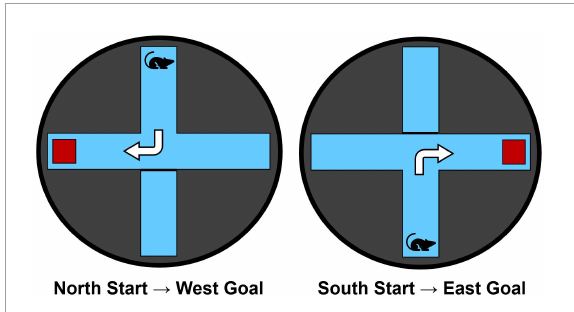
FIGURE1 The water maze apparatus and overview of the dorsolateral striatal-dependent response learning task. Starting points from the north and south arms are counterbalanced across trials and training days. Animals are trained to make a consistent body-turn response to reach the hidden escape platform (red square) for 6 trials/day over 7 consecutive training